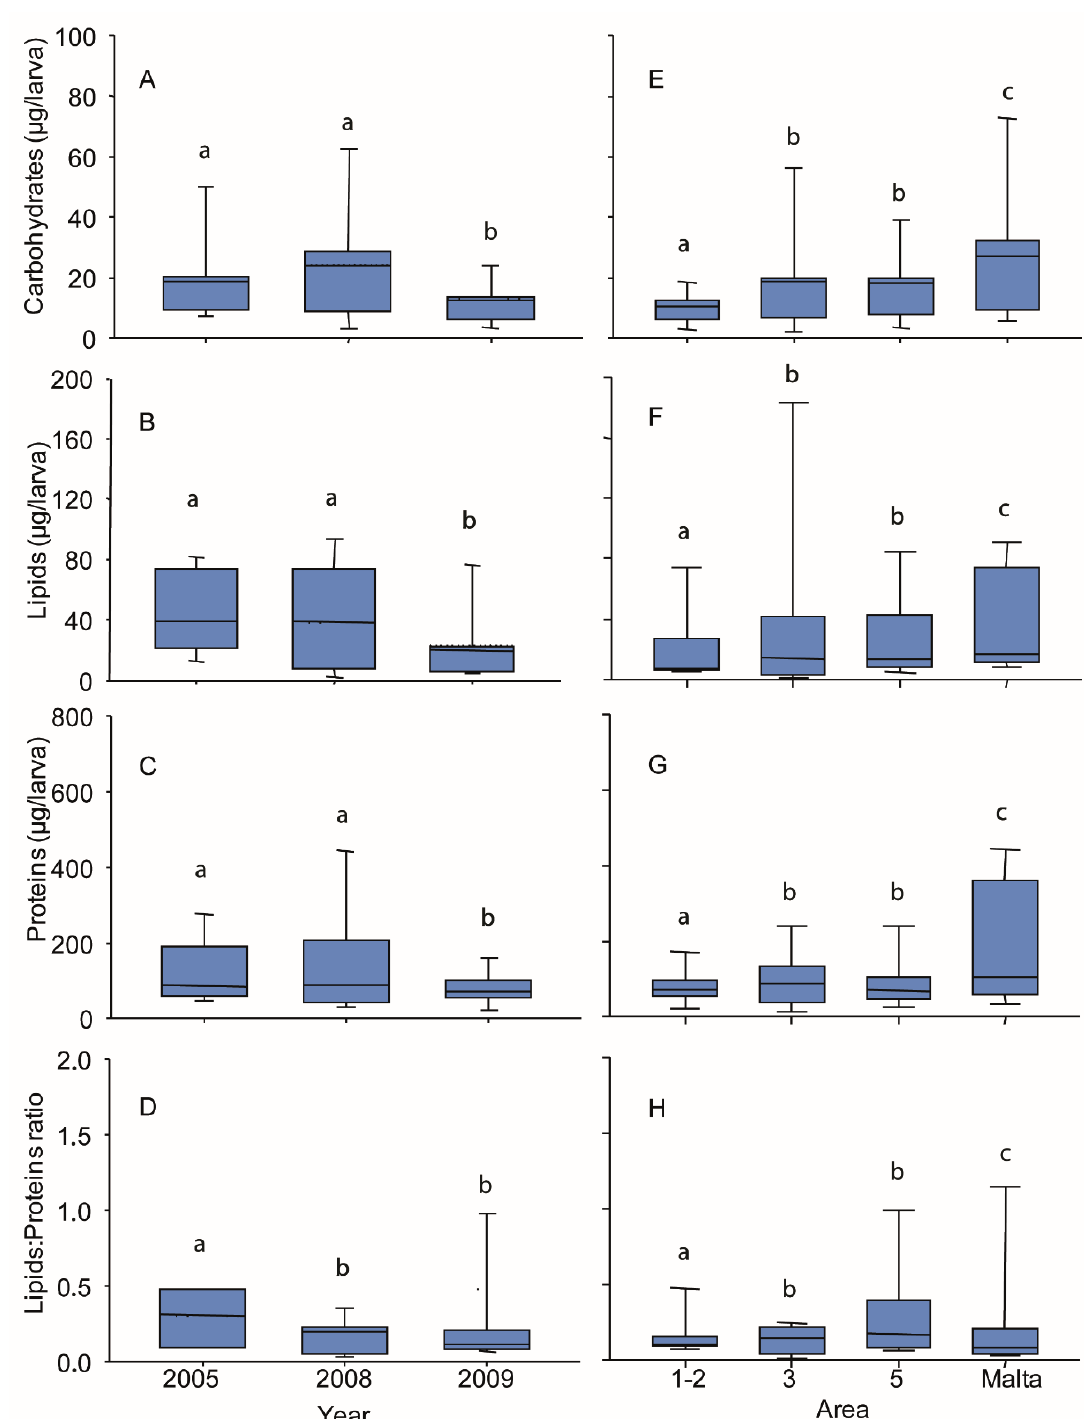
Figure 9 . Biochemical content box plots. ( A – D ) Larval carbohydrates, lipids and proteins content and lipid–protein ratio observed in the different years. ( E – H ) Larval carbohydrates, lipids and proteins content and lipid–protein ratio observed in the different areas. In all cases, the bottom and top of the boxes are the first and third quartiles, while the whiskers indicate the 10 and 90 percentiles, and the band inside is the mean value. Lowercase letters (a–c) indicate statistically significant difference among groups (permutational t tests, p -value < 0.05).